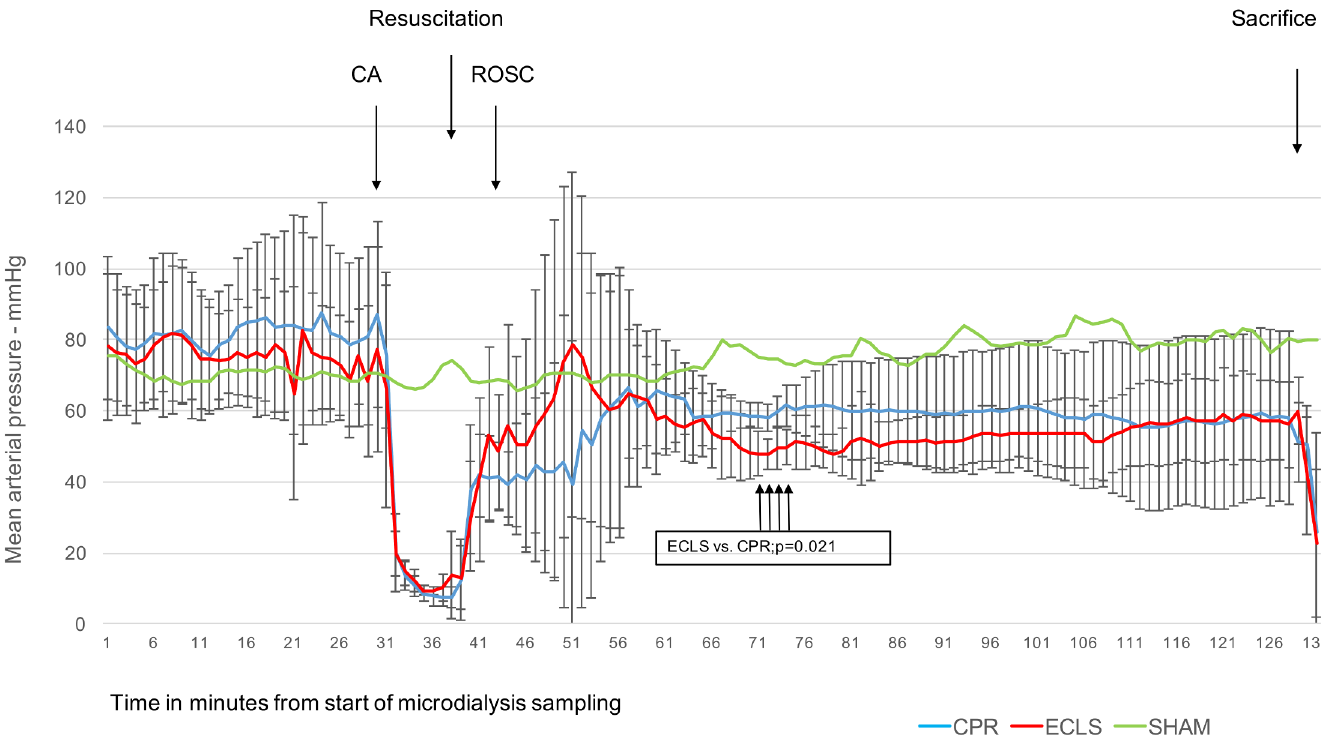
Fig 2. Mean arterial blood pressure in mm Mercury against time. X-axis: time in minutes; Y-axis: mean arterial blood pressure invasively measured in mmHg (mean with standard deviation); VFCA, ventricular fibrillation cardiac arrest; ROSC, return of spontaneous circulation; ECLS, extracorporeal life support; CPR, cardiopulmonary resuscitation; The p value displayed results from comparison of mean values the interval of measurements min 70 to 74.